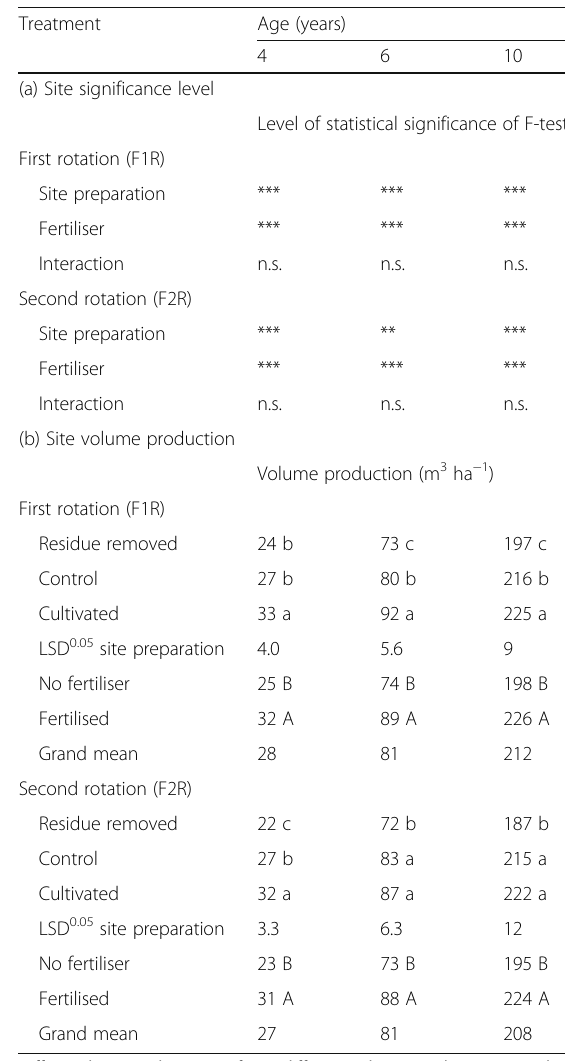
Different letters indicate significant differences between the means at the 5% level within each rotation and age. Lowercase letters for site preparation and uppercase for fertiliser n.s. not significantly